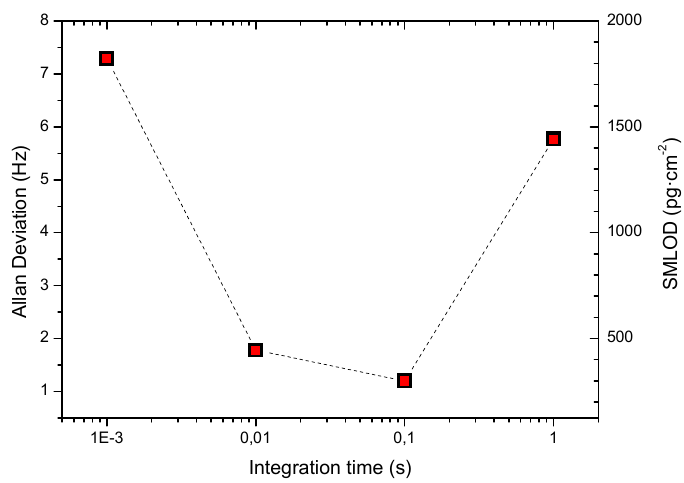
Figure 7. Allan deviation as a function of integration time measured in air conditions (atmospheric pressure and ambient temperature). The corresponding surface mass limit of detection (SMLOD) for each integration time is indicated in the right y-axis.